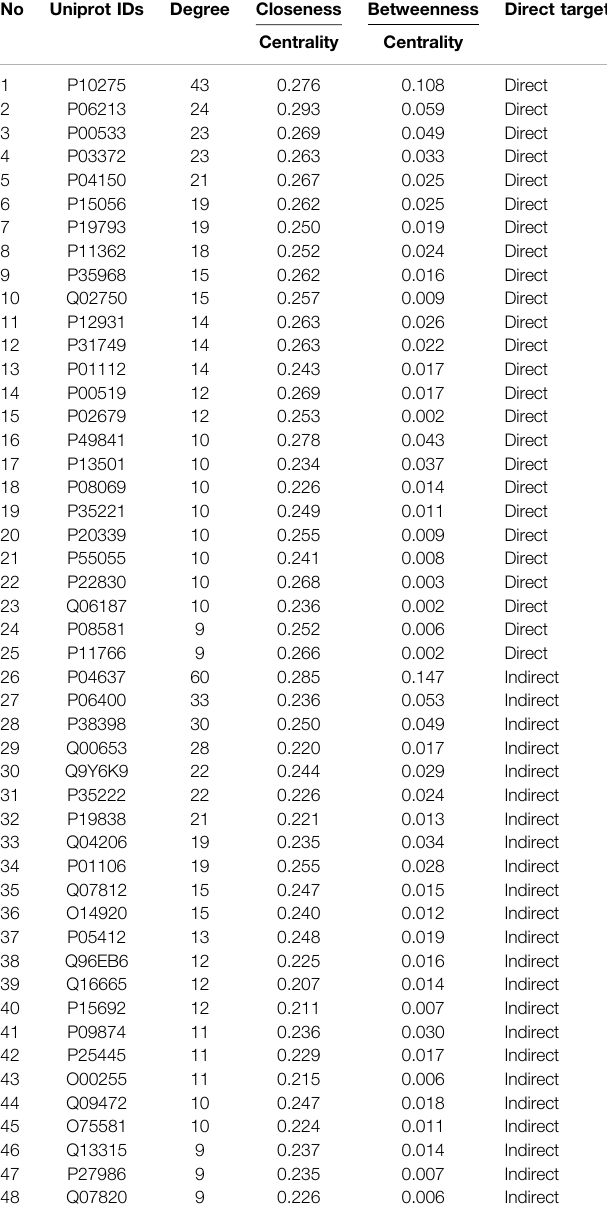
TABLE 1 | The targets related liver